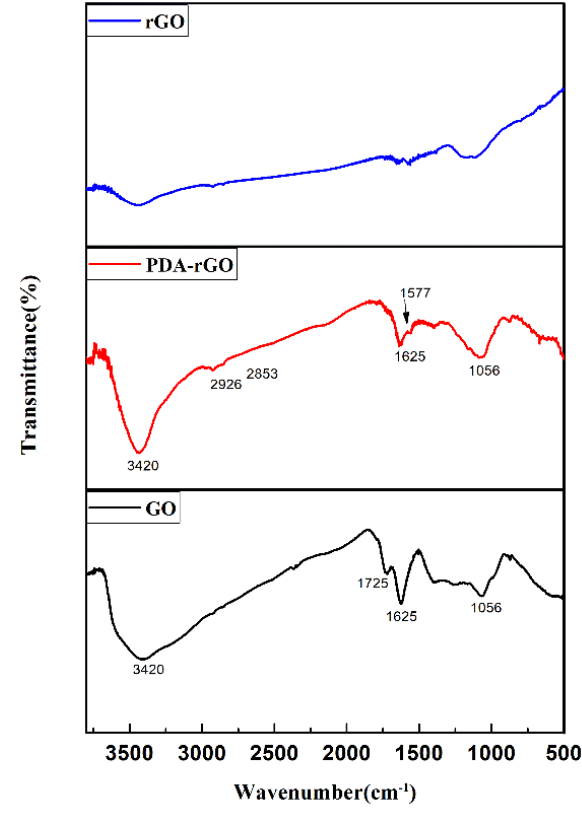
Figure 3. FTIR spectra of GO, rGO and PDA − rGO.